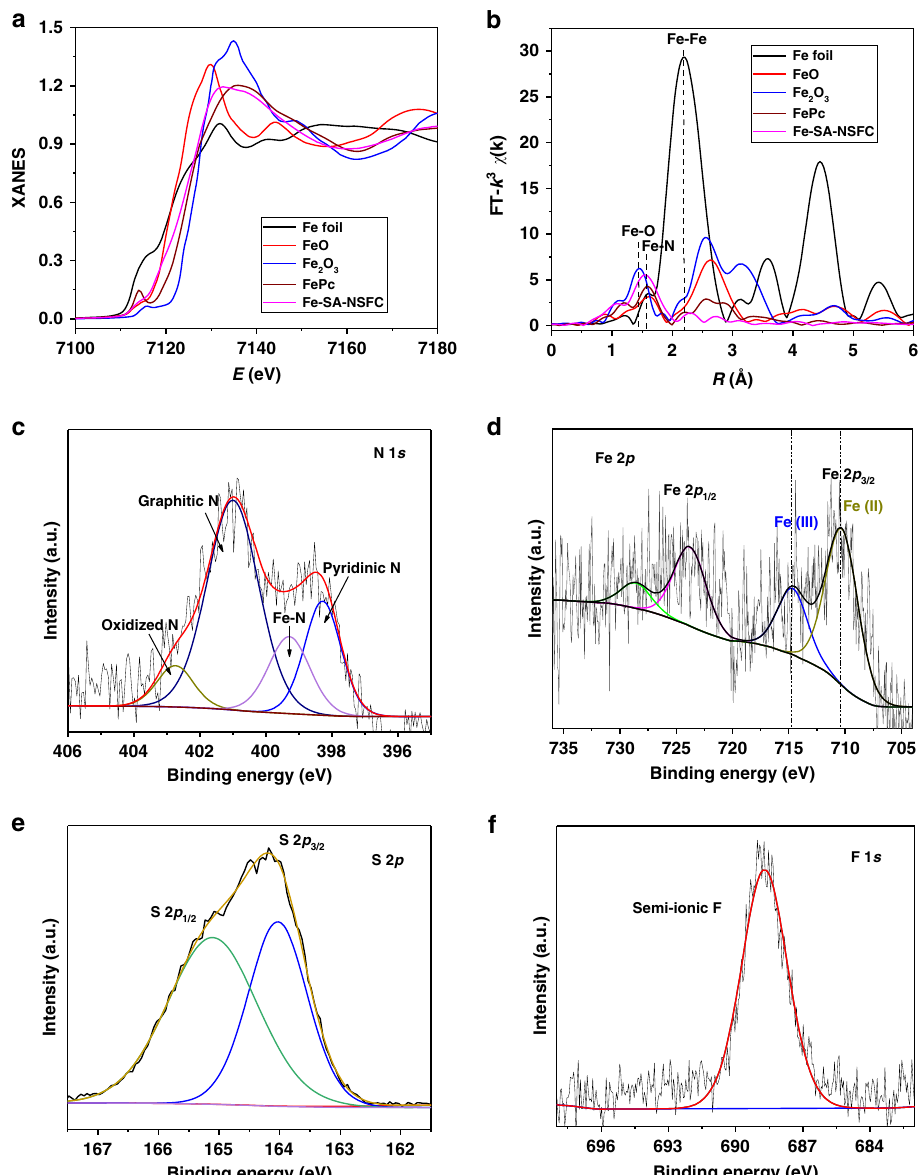
Fig. 2 Atomic structure analysis. a Fe K-edge XANES spectra and b FT of k 3 -weighted χ ( k )-function of EXAFS spectra of Fe-SA-NSFC, where an Fe foil, FeO, Fe 2 O 3 , and FePc were used as reference materials. High-resolution X-ray photoelectron spectroscopy (XPS) spectra of c N 1 s , d Fe 2 p , e S 2 p , and f F 1 s